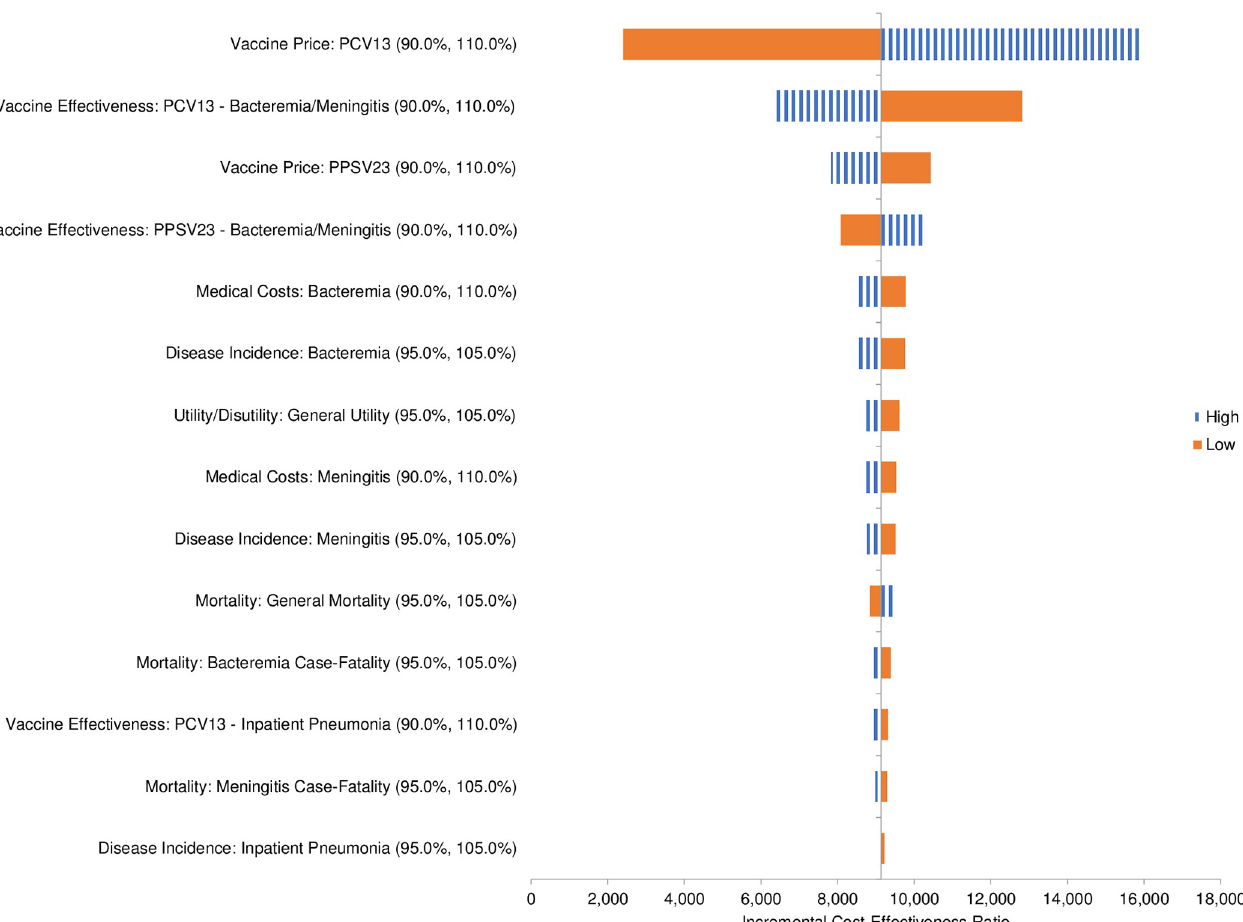
Fig 3. One-way deterministic sensitivity analyses for the private health care sector mixed model. Incremental cost-effectiveness ratio is indicated in 2015 South African rand/QALY.